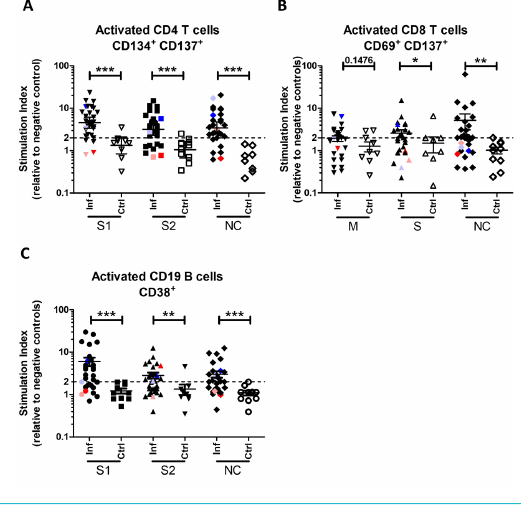
Figure 2: COVID-19 convalescent individuals were distinguishable from naïve individuals. (A) Activated CD4+ T cells (CD134+ CD137+) 5 days post-incubation with SARS-CoV-2 re- combinant S1, S2 or nucelocapsid proteins. (B) Activated CD8+ T cells (CD69+ CD137+) 5 days post-incubation with mixtures of SARS-CoV-2 synthetic membrane peptides (11 total), S peptides (28 total), or nuceocapsid peptides (18 total). (C) Activated CD19+ B cells (CD38+) 5 days post-incubation with SARS-CoV-2 recombinant S1, S2 or nuceocapsid proteins. Dotted line at SI = 2 indicates activation threshold. Coloured symbols represent the four convalescent individuals with no detectable anti-S antibodies. S: spike; M: membrane; NC: nucleocapsid; Inf: infected; Ctrl: unex- posed donor control. Error bars in the graph indicate mean ± SEM. Statistics: Mann Whitney t test.